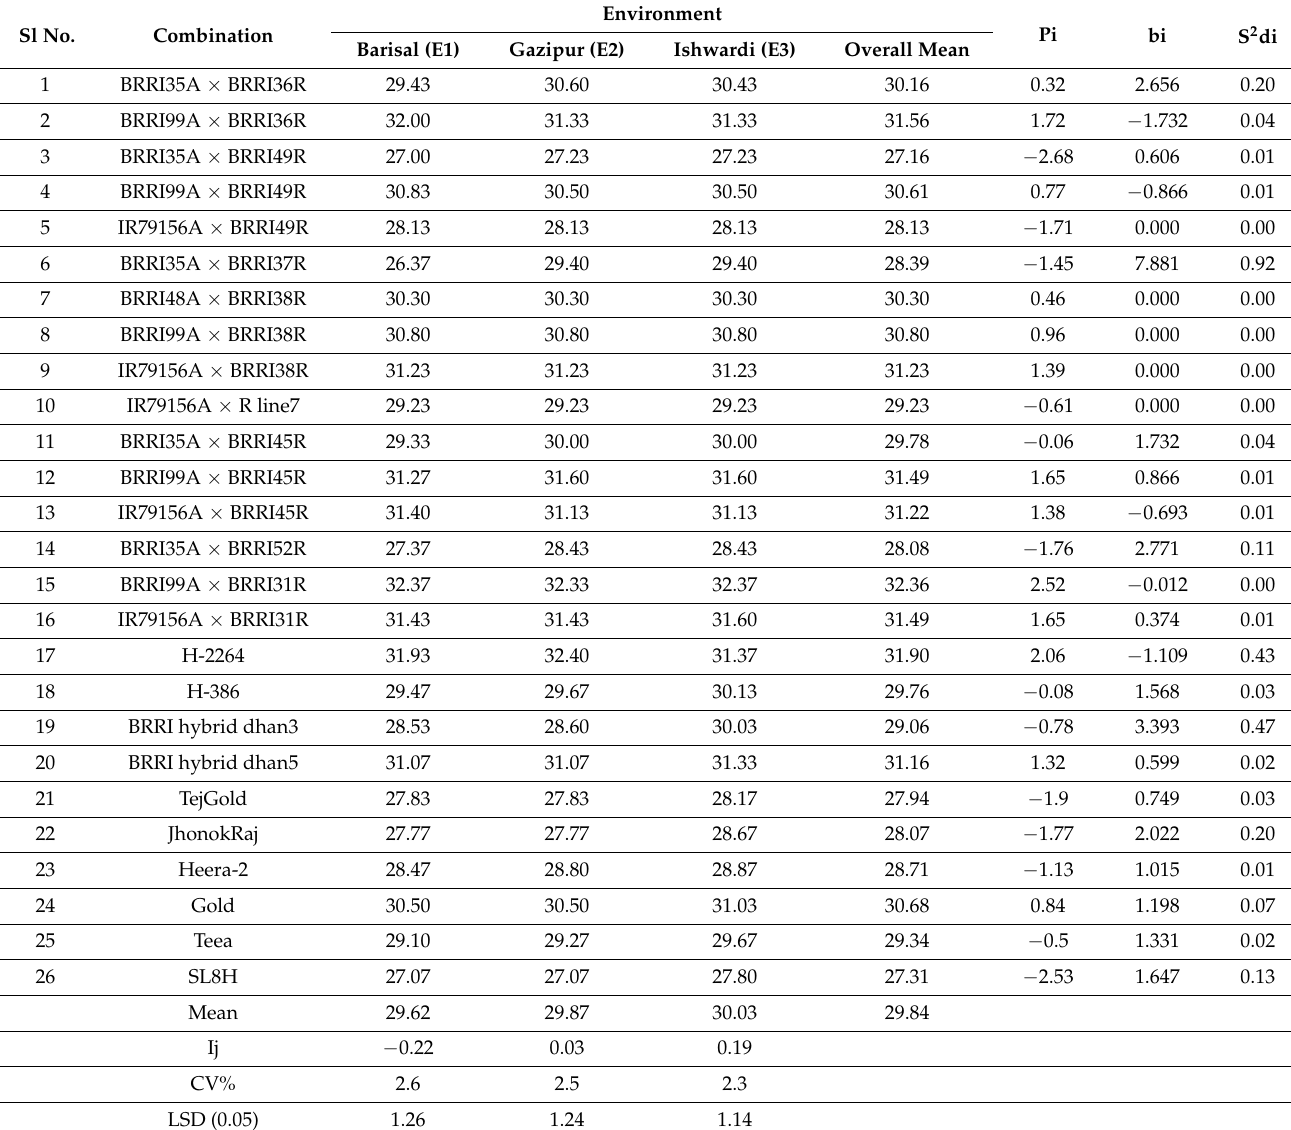
Table 9. Stability analysis for flag leaf length of 26 hybrid combinations at three